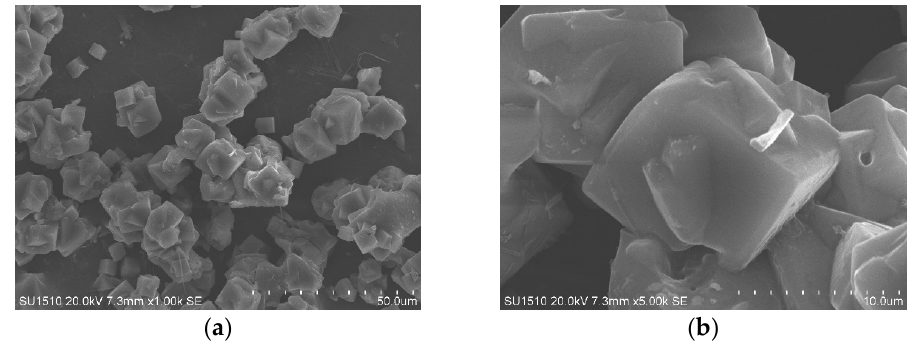
Figure 2. ( a ) Low magnification and ( b ) high magnification SEM images of the as-made S–Si–SOD zeolite synthesized at 200 °C.